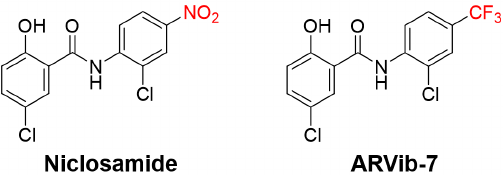
Figure 6. Structure of niclosamide and its analog,